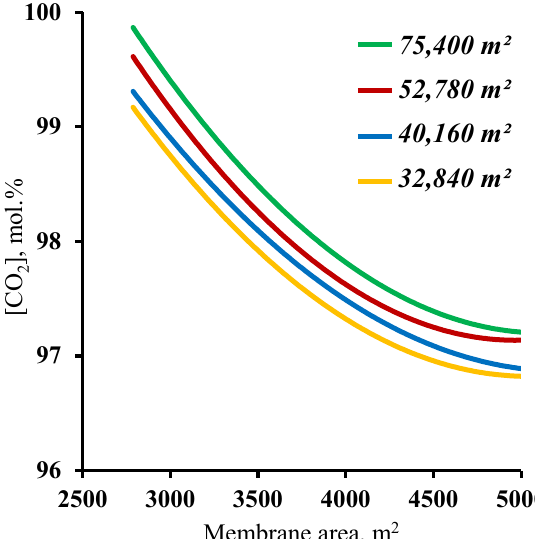
Figure 8. Dependence of carbon dioxide content in the product stream (withdrawn from the cascade enrichment section) on the membrane area in the enrichment section (M2 and M3) for four different fixed membrane area values in the stripping section.